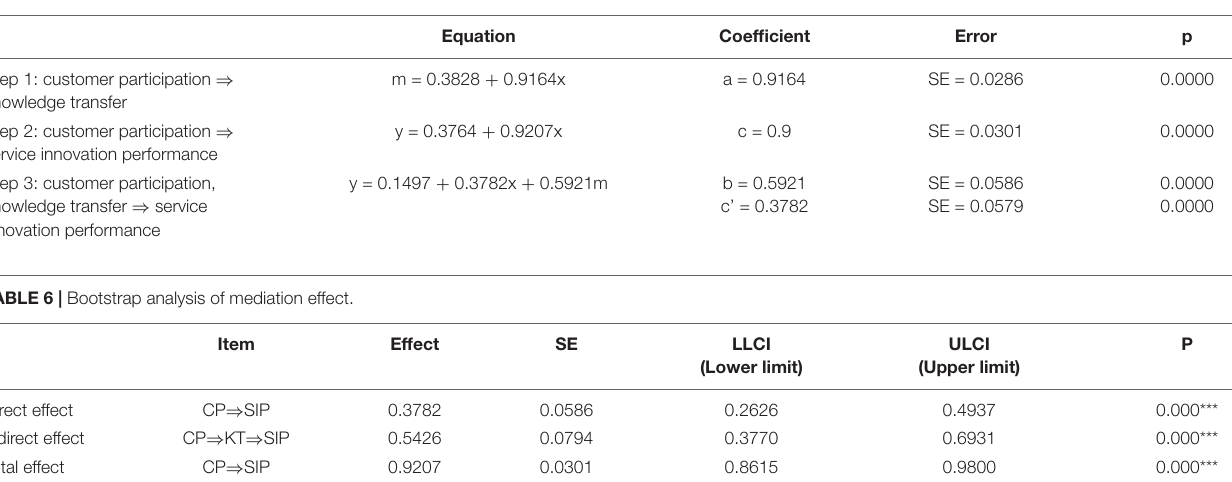
TABLE 5 | Regression test of the mediating effect of knowledge transfer.